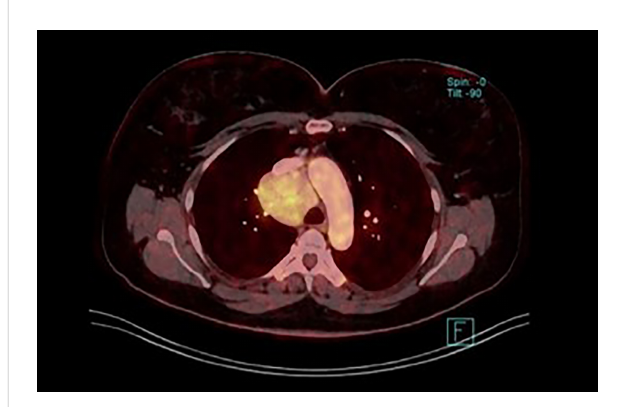
FIGURE 6 Unicentric CD in the mediastinum (fused image of the fl uordeoxyglucose uptake and postcontrast CT from whole body PET/CT